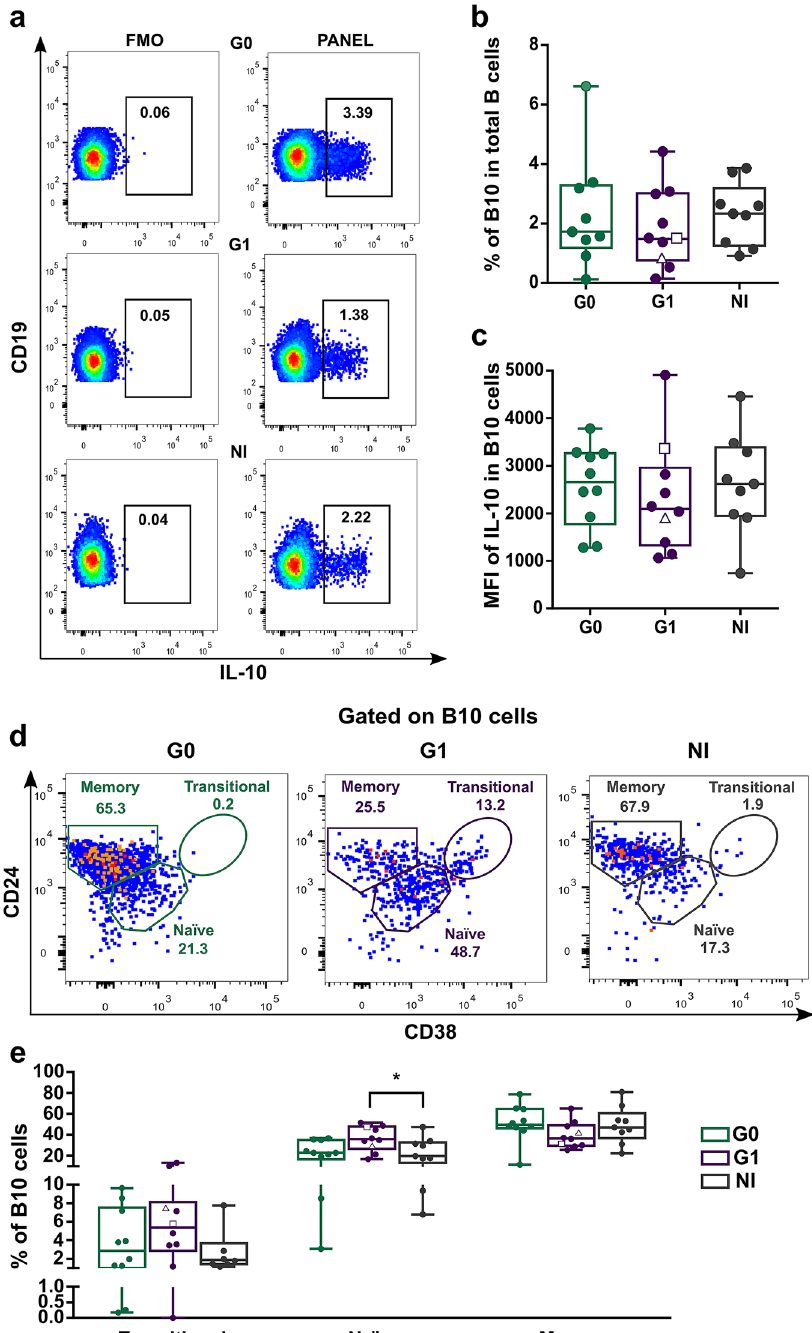
Figure 3. Frequency and phenotypic distribution of B10 cells according to CD24 and CD38 expression in peripheral blood from CCD patients and non-infected donors. ( a ) Representative dot plots showing the gating strategy used to determine the IL-10 + B cells (B10 cells) in PIB stimulated PBMC. Fluorescence minus one controls (FMO) were used to define the negative populations for each sample. ( b , c ) Frequency of B10 cells in total B cells and mean fluorescence intensity (MFI) for IL-10 + in B10 cells in CCD patients (G0, G1) and non- infected donors (NI). ( d ) Representative dot plots showing the gating strategy used. IL-10 expressing B-cells (B10 cells) were gated according to subject- and condition-matched FMO control tubes and were further sub-gated using CD24 and CD38 to identify the phenotypical distribution of these populations. ( e ) Frequency distribution of B10 cells according to CD24 and CD38 expression in CCD patients (G0, G1) and non-infected donors (NI). Each dot represents data from one subject; inside G1 group, solid circles correspond to K1 patients, hollow triangle to K2 patient and hollow square to K3 patient. Boxes and whiskers show median value and interquartile range. Statistically significant differences among groups are indicated (* p <